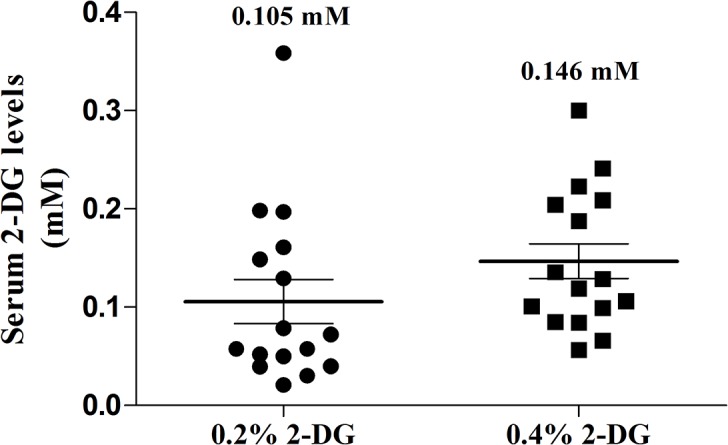
Circulating levels of 2-DG.The 2-DG concentration in the serum of mice administered with drinking water containing 0.2% and 0.4% 2-DG (w/v). No traces of 2-DG were found in the control animals as expected. 2-DG levels were estimated fluorimetrically based on the acid catalyzed condensation of DABA with 2-DG, with some modifications in the method described by Blecher (44). For detailed protocol, see Material and Methods.